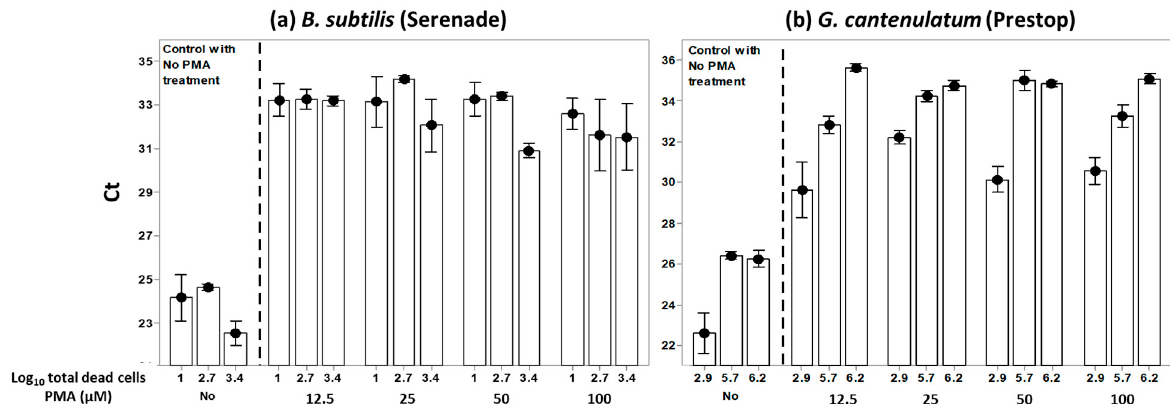
Figure 3. ( a ) Impact of PMAxx™ concentrations on blocking DNA amplification of increasing log 10 total dead cells from B. subtilis ; ( b ) Impact of PMAxx™ concentrations on blocking DNA amplification of increasing log 10 total dead cells from G. catenulatum . Each treatment combination contained two independent biological replicates, and each biological replicate was carried out in triplicate on the qPCR plate. The mean is represented by the black circles, and the bars represent the